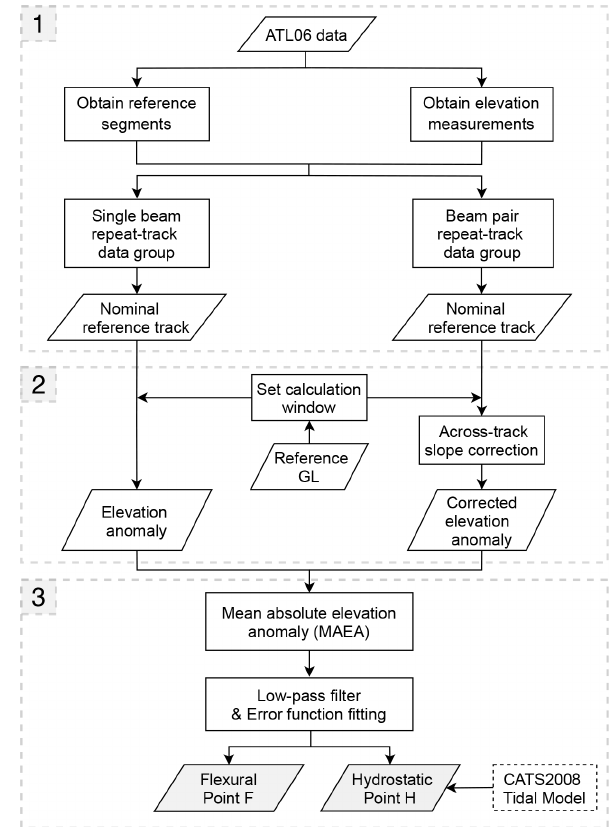
Figure 3. The ICESat-2 repeat-track workflow used to identify the grounding zone (GZ) in this study, including the limits of inland tidal flexure (Point F) and hydrostatic equilibrium (Point